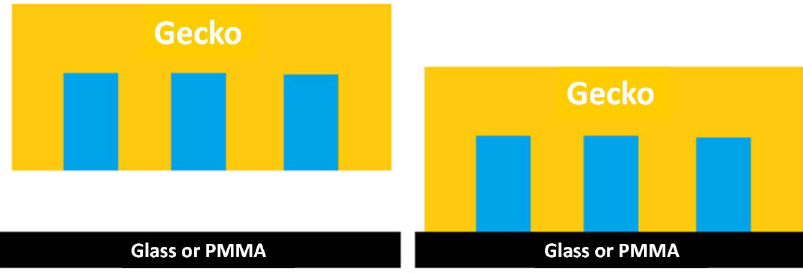
Figure 3. Schematic of the work of adhesion model geometry. Schematic depicts a patterned gecko surface (pattern of four setae represented as yellow pillars) filled with water (blue) both prior to and during contact with the substrate (either glass or PMMA) in air (white